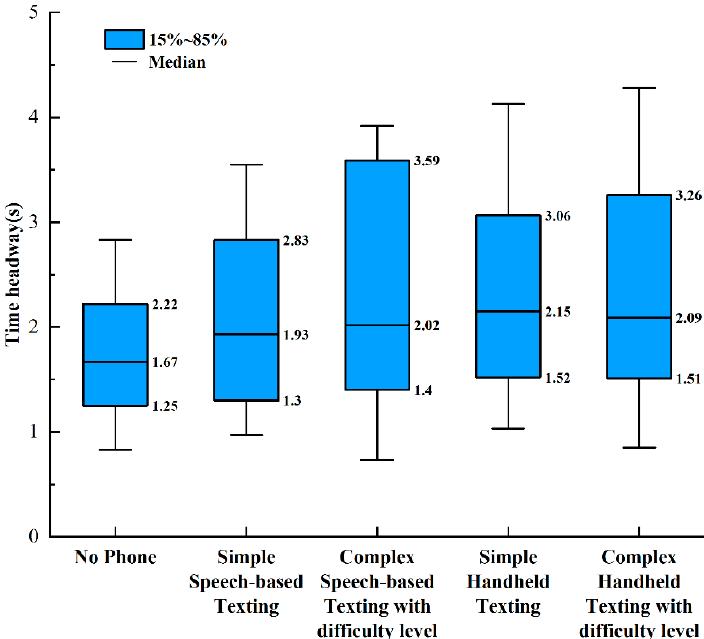
Figure 2. Boxplots of initial time headway in different driving conditions.